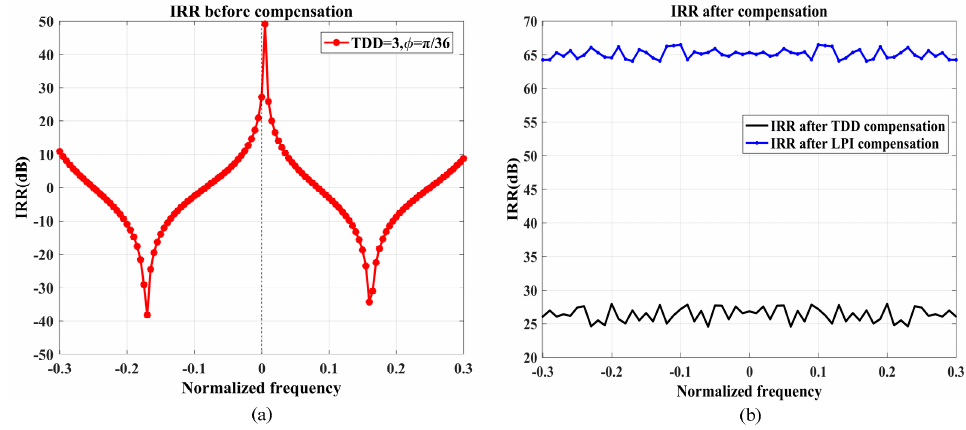
Figure 5. IRR curves: ( a ) IRR before any compensation and ( b ) IRR after compensation.